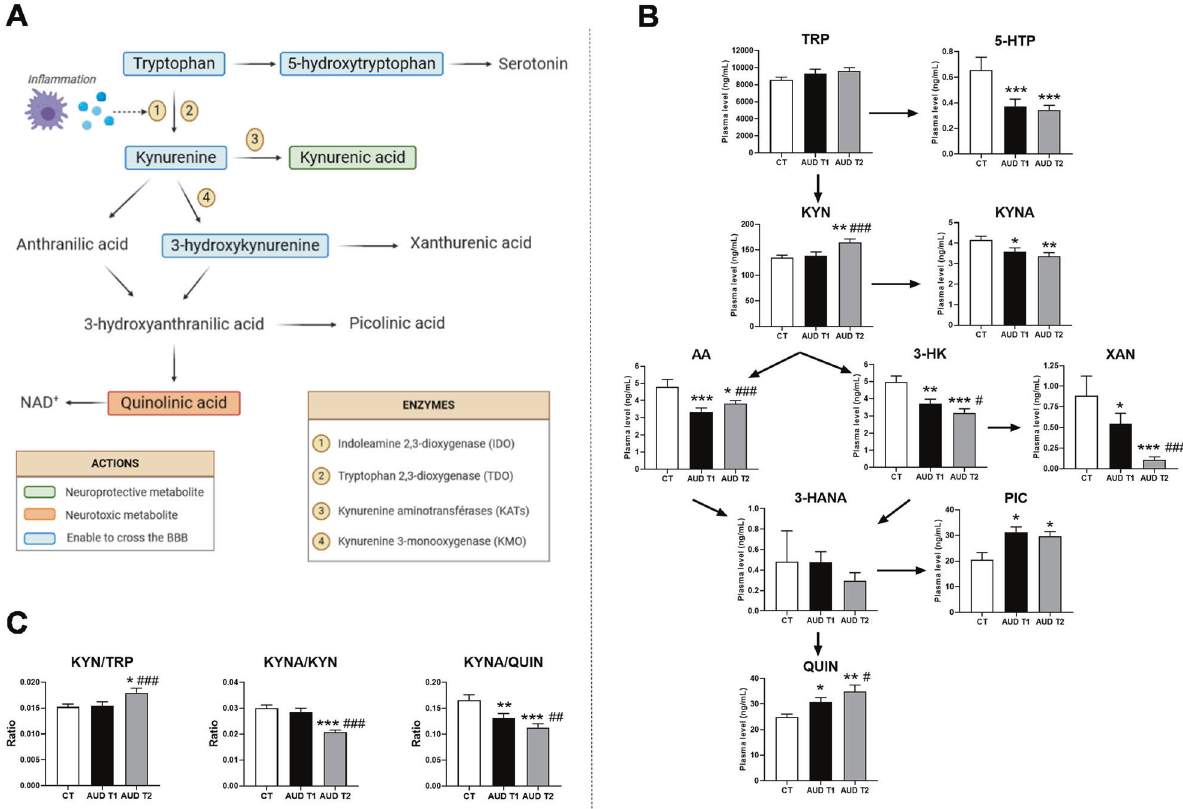
Fig. 1 The tryptophan-kynurenine pathway and its related metabolic ratios. A The essential amino acid tryptophan (TRP) is the precursor of 5-hydroxytryptophan (5-HTP) which forms serotonin. However, the majority of peripheral TRP enters the kynurenine pathways thanks to two rate-limiting enzymes: the liver tryptophan 2,3-dioxygenase (TDO) and the extra-hepatic indoleamine 2,3-dioxygenase (IDO). The activity of IDO is negligible under basal conditions but dramatically inducible by in fl ammatory signals. Kynurenine (KYN) can be then metabolized through three distinct pathways to form kynurenic acid (KYNA), 3-hydroxykynurenine (3-HK) and anthranilic acid (AA) by the action of kynurenine aminotransferase (KAT), kynurenine 3-monooxygenase (KMO) and kynurenase enzymes, respectively. 3-HK can be further converted into xanthurenic acid (XAN), whereas both 3-HK and AA may be enzymatically converted to 3-hydroxyanthranilic acid (3-HANA), which in turn form picolinic acid (PIC) and quinolinic acid (QUIN). The fi nal product of the pathway is nicotamine adenine dinucleotide (NAD + ), an important cofactor in cellular reactions linked to energy metabolism. B Plasma concentration of TRP and kynurenine metabolites of healthy controls (CT) and AUD patients at the onset (T1) and end (T2) of a 3-week detoxi fi cation program. C Ratio of metabolites re fl ecting the sum of IDO and TDO activities (KYN/TRP), KATs activity (KYNA/KYN) and the balance between neuroprotective and neurotoxic metabolites (KYNA/QUIN) in healthy controls and AUD patients during alcohol withdrawal. Results are expressed as mean ± SEM, n = 57 AUD patients and 16 CT subjects. * P < 0.05 vs. CT; ** P < 0.01 vs. CT; *** P < 0.001 vs. CT; # P < 0.05 vs. AUD T1; ## P < 0.01 vs. AUD T1; ### P < 0.001 vs. AUD